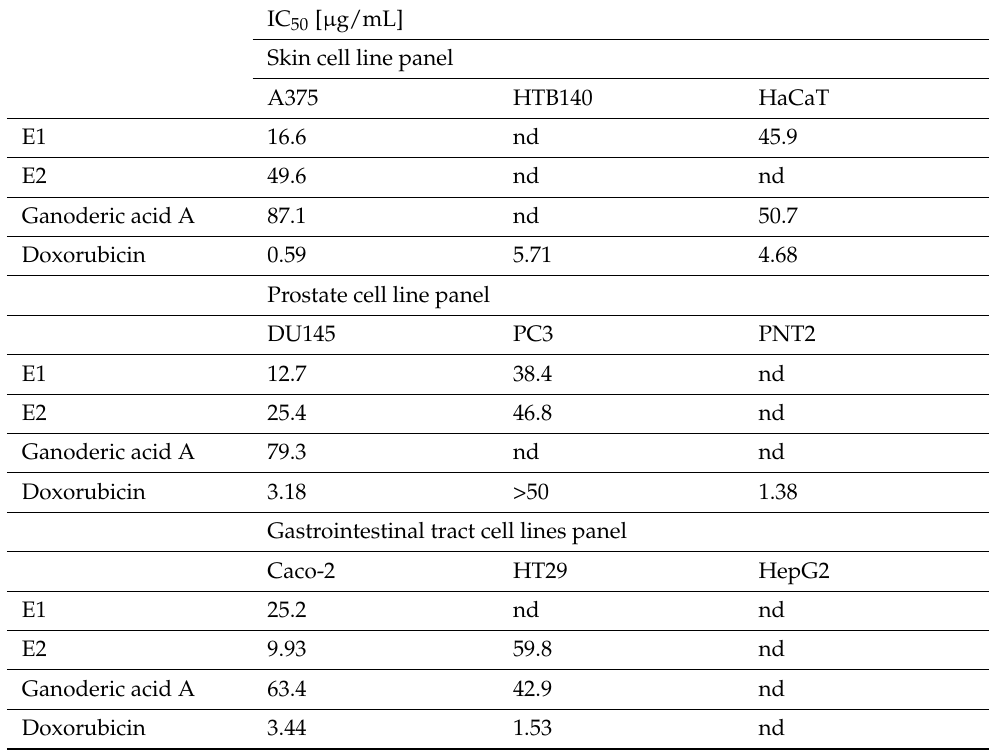
Table 3. The effect of extracts and ganoderic acid A acid on the viability of the selected cell lines expressed as IC 50 (the concentrations that induced a 50% decrease in cell viability after 24 h of treatment). IC 50 [ µ g/mL] Skin cell line panel A375